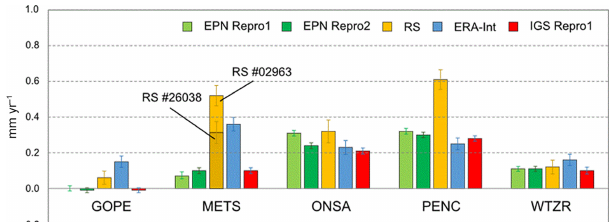
Figure 15. ZTD trend comparisons at five EPN stations for five dif- ferent ZTD data sets. The error bars are the formal errors of the estimated trend